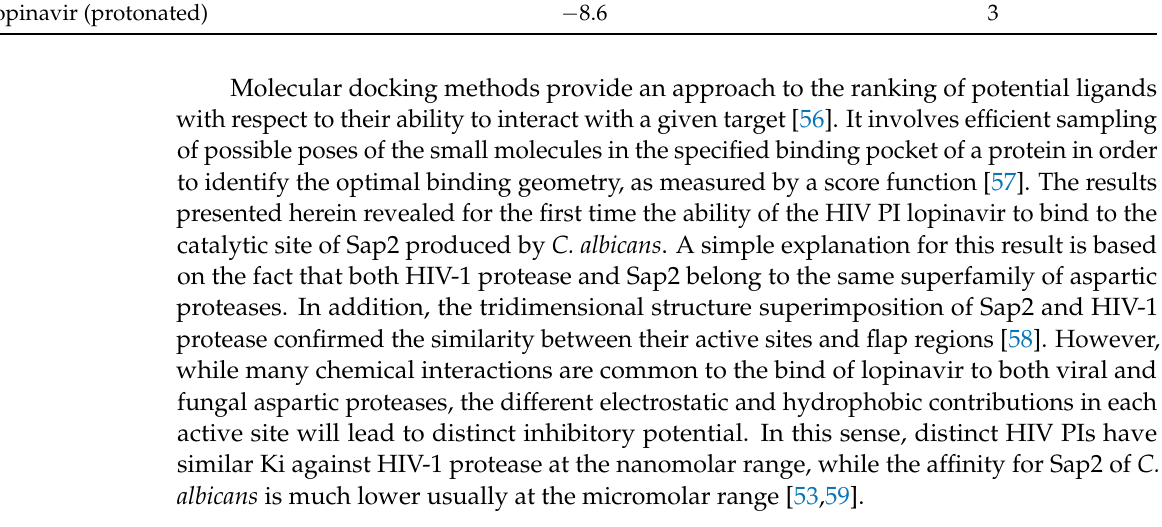
Table 1. Molecular docking binding free energies and associated ranking to the different ligands when interacting with C. albicans Sap2 catalytic site (D 32 , D 218 and G 85 ). Ligands Estimated Binding Free Energy (kcal/mol) Cluster Ranking A70450 (standard inhibitor, protonated form) − 9.5 1 Lopinavir (unprotonated) − 9.0 Lopinavir (protonated) −